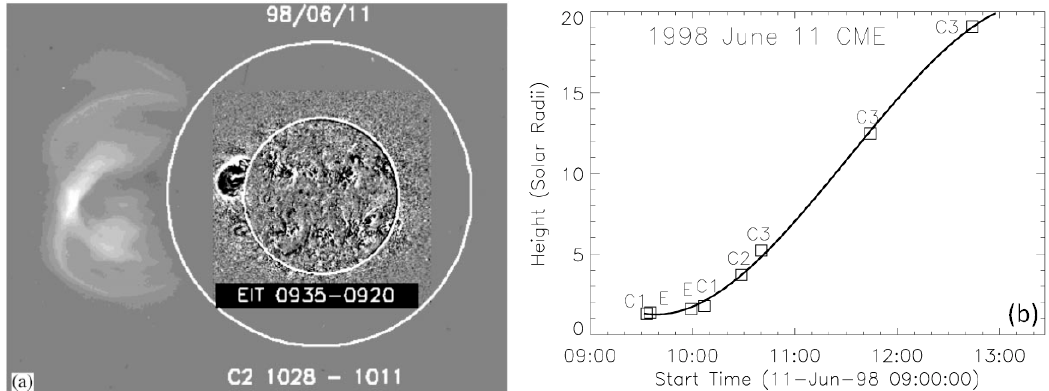
Figure 3. ( a ) The 1998 June 11 CME at two different instances: in the SOHO/EIT FOV at 09:35 UT and in the LASCO/C2 FIV at 10:28 UT. The CME was also observed in the LASCO/C1 FOV (not shown). The inner and outer white circles represent the solar disk and the LASCO/C2 occulting disk, respectively. ( b ) CME height–time plot that combines SOHO/LASCO (C1, C2, C3) and EIT (E) observations. The solid curve is a third-order polynomial fit to the data points (adapted from [46]).